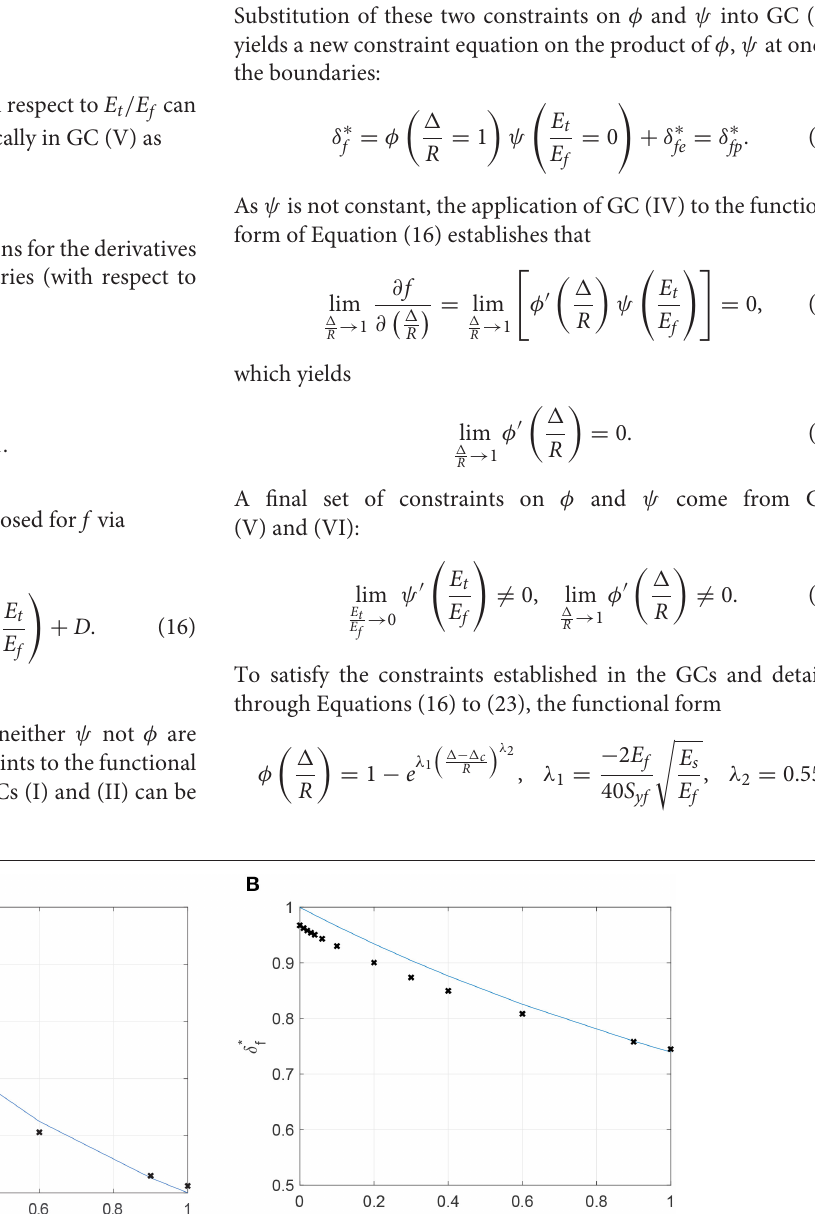
Frontiers in Mechanical Engineering | www.frontiersin.org